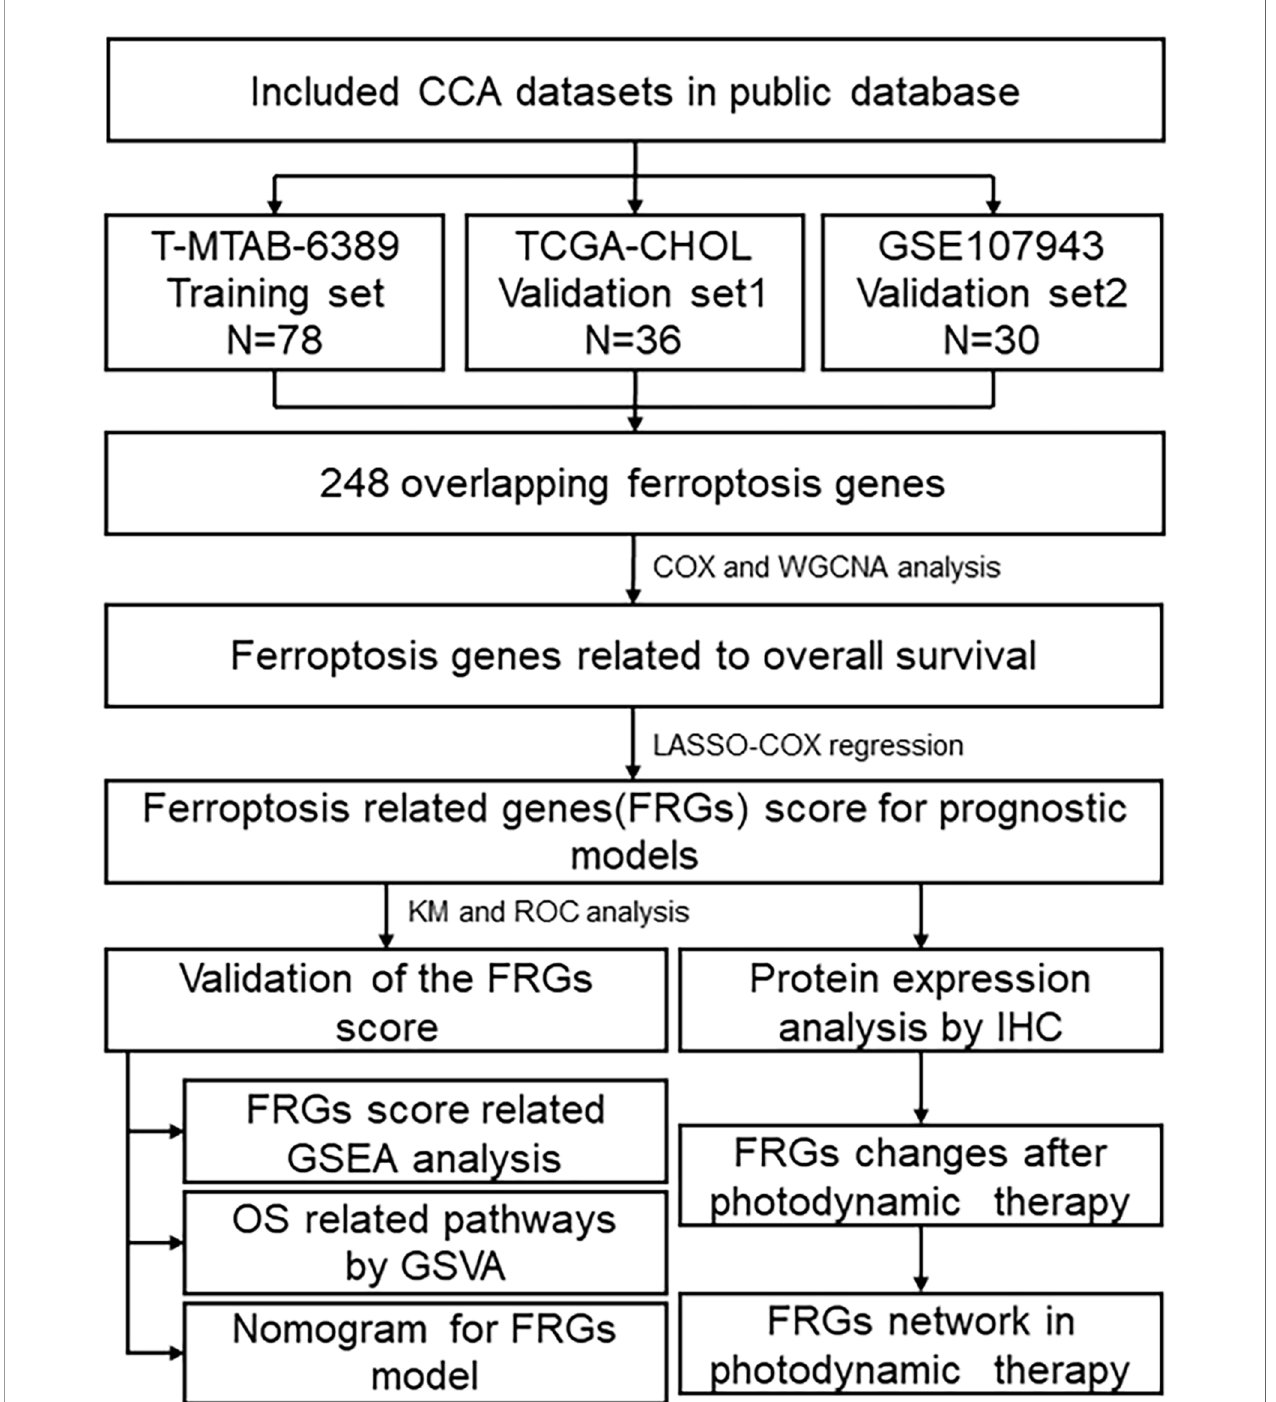
FIGURE 1 | Flowchart describing the process used to identify and validate the Fer-score model of